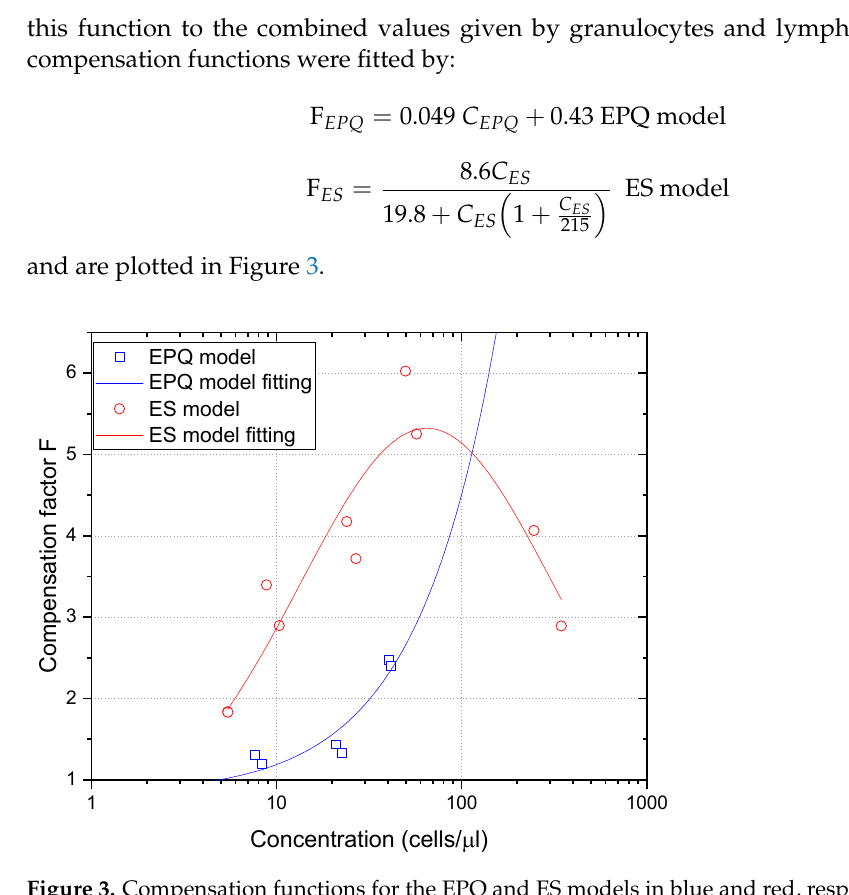
Figure 3. Compensation functions for the EPQ and ES models in blue and red, respectively.